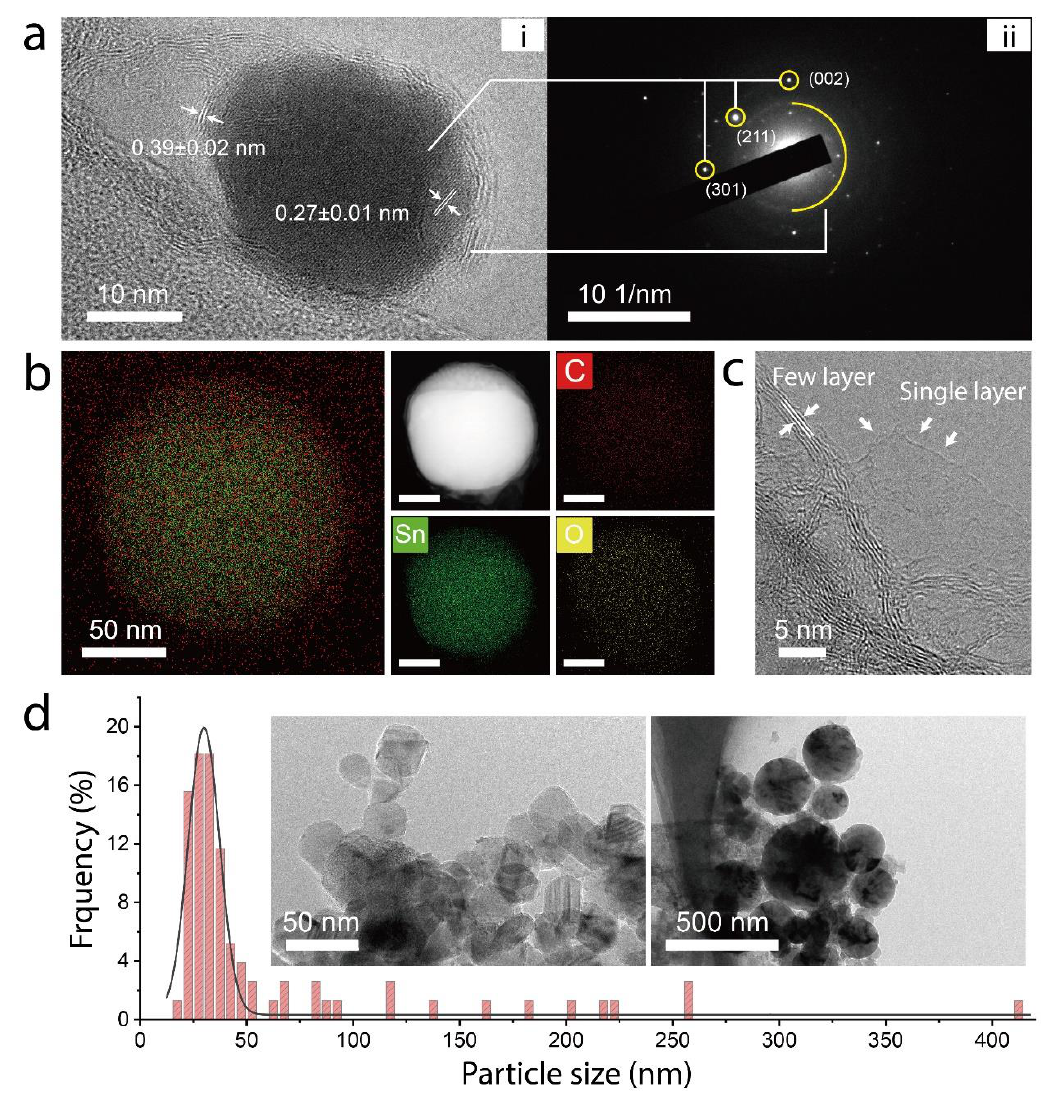
Figure 1. ( a ) i: The high-resolution TEM image of the Gr-SnO 2 nanoparticle and ii: the selected area’s electron diffraction pattern corresponding to crystalline SnO 2 . The interplanar spacing of the SnO 2 core and graphene outer layer is determined to be 0.27 ± 0.01 and 0.39 ± 0.02 nm. ( b ) The HAADF-STEM image along with the elemental analysis of the Gr-SnO 2 nanoparticle. ( c ) The TEM images of single-layer and few-layer free-standing graphene nanosheets. ( d ) The histogram of the particle sizes of the Gr-SnO 2 nanoparticles. The insets are the TEM images of the Gr-SnO 2 nanoparticles.